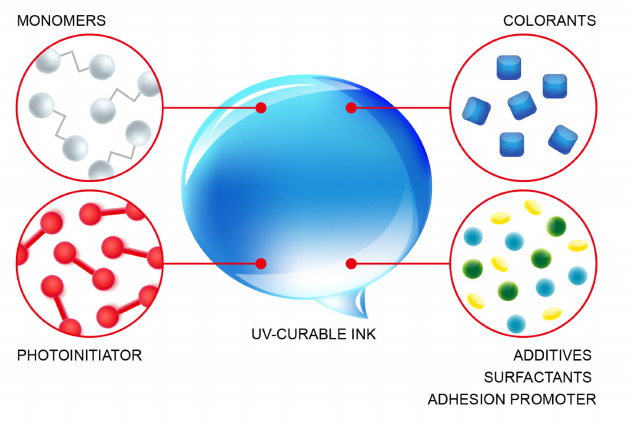
Figure 1. UV-curable ink comprises the compounds: monomers, colorants, photoinitiator, and additives.